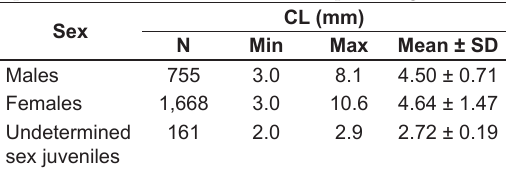
Table 1. Number of individuals (N), minimal (Min) and maximal (Max) length, mean and standard deviation (SD) of length carapace of M. amazonicum specimens